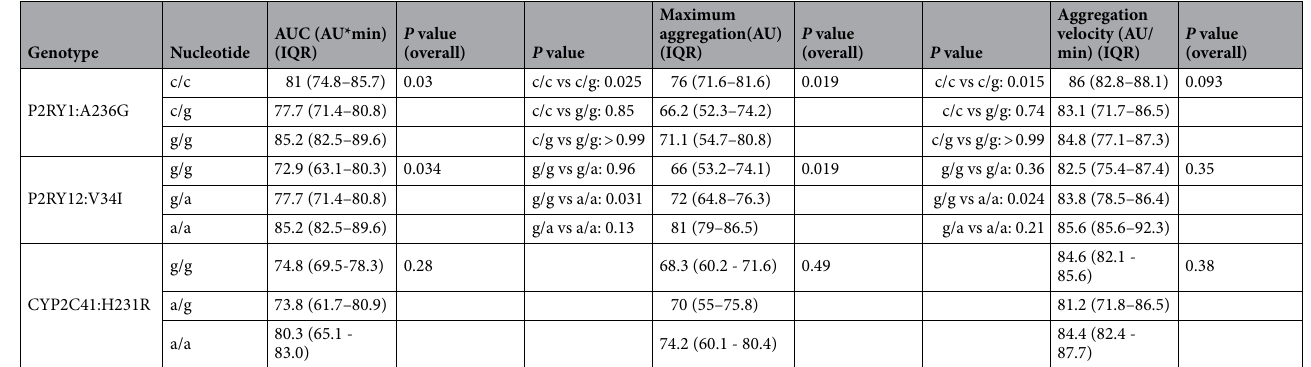
Table 2. The percent inhibition (interquartile range [IQR]) of area under the curve (AU*min), maximum aggregation (AU), and aggregation velocity (AUC/min), measured by whole blood aggregometry, in cats with the wildtype (WT) and the variant genotype (both homozygous and heterozygous) in various genotypes (P2RY1:A236G, P2RY12:V34I, and CYP2C41:H231R). AUC area under the curve, IQR interquartile range.